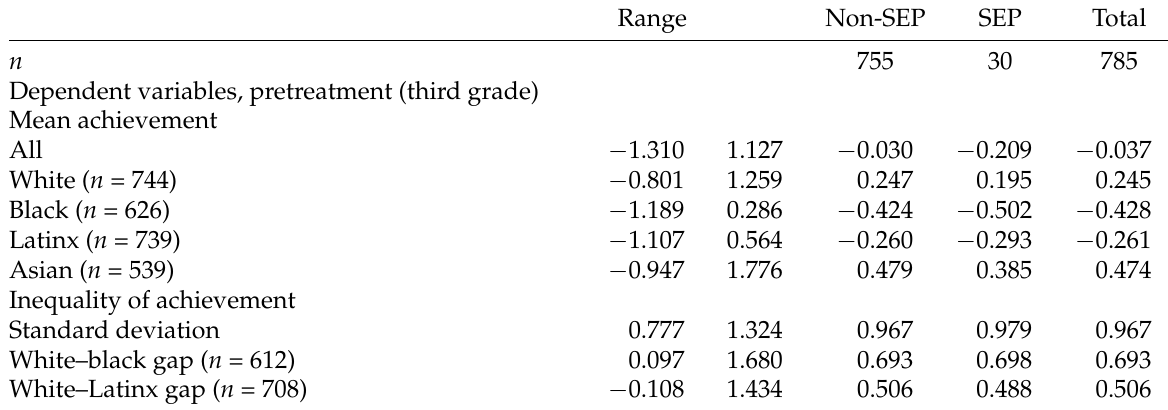
Table 1: Pretreatment (third grade) dependent variables, averaged 2009 to